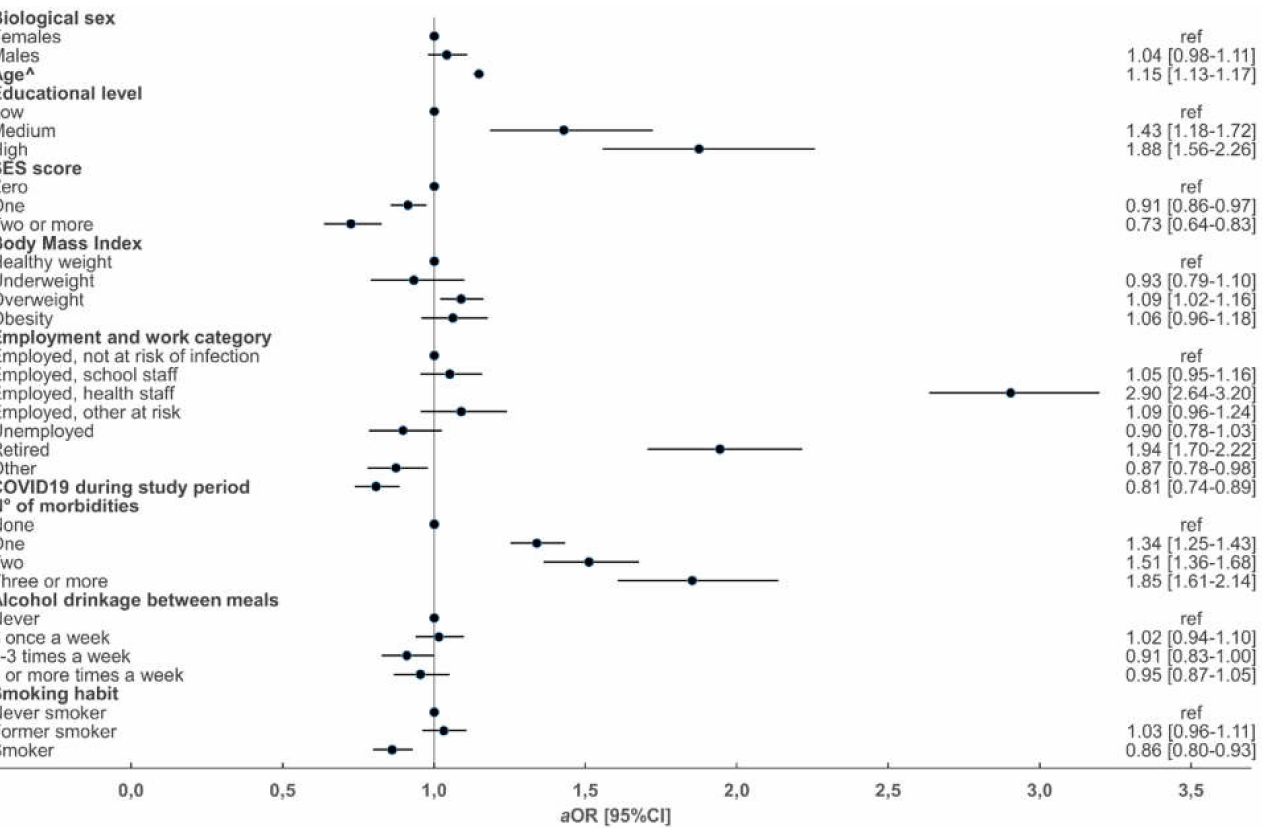
Figure 1. Forest plot of the results from multivariate multinomial logistic regression models of factors associated with flu shot uptake in the 2020/2021 season in respondents aged <65 years. ˆ For each additional 5 years of age. ref, reference category; a OR, adjusted odds ratios; 95% CI, 95% confidence